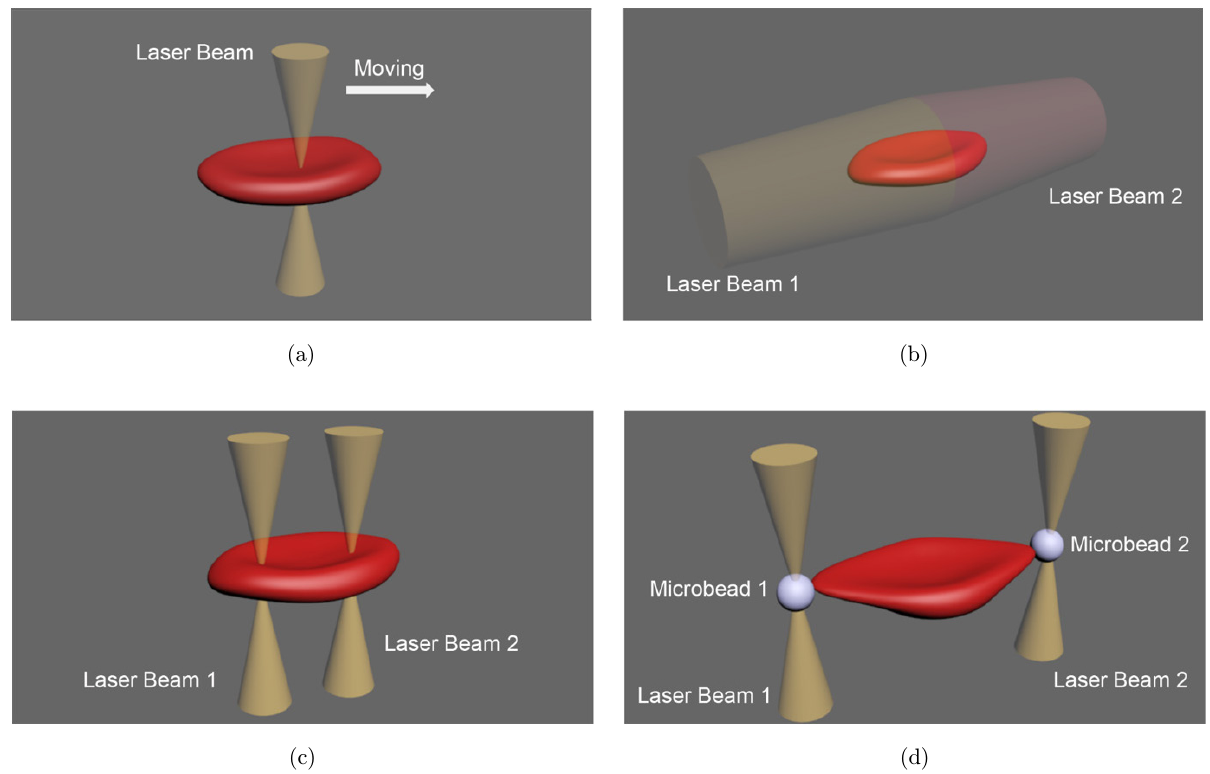
Fig. 2. Schematic of di®erent optical tweezers on erythrocyte. (a) The erythrocyte deforms when moving with the single-beam optical tweezer. (b) The optical stretcher uses two nonfocused laser beams from opposite directions to deform the erythrocyte. (c) The dual-trap optical tweezer applies two parallel beams focused in the interior of the erythrocyte. (d) The laser beams stretch the erythrocyte through microbeads attached to the